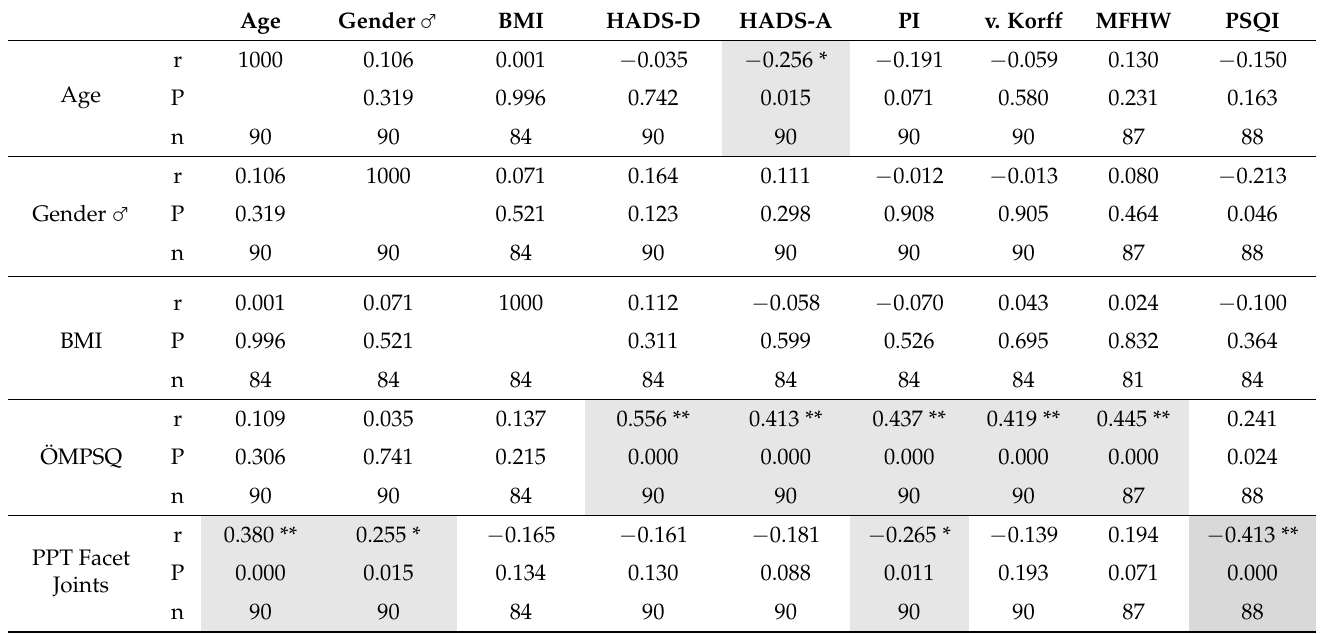
Table 5. Correlations of demographics, questionnaire scores and